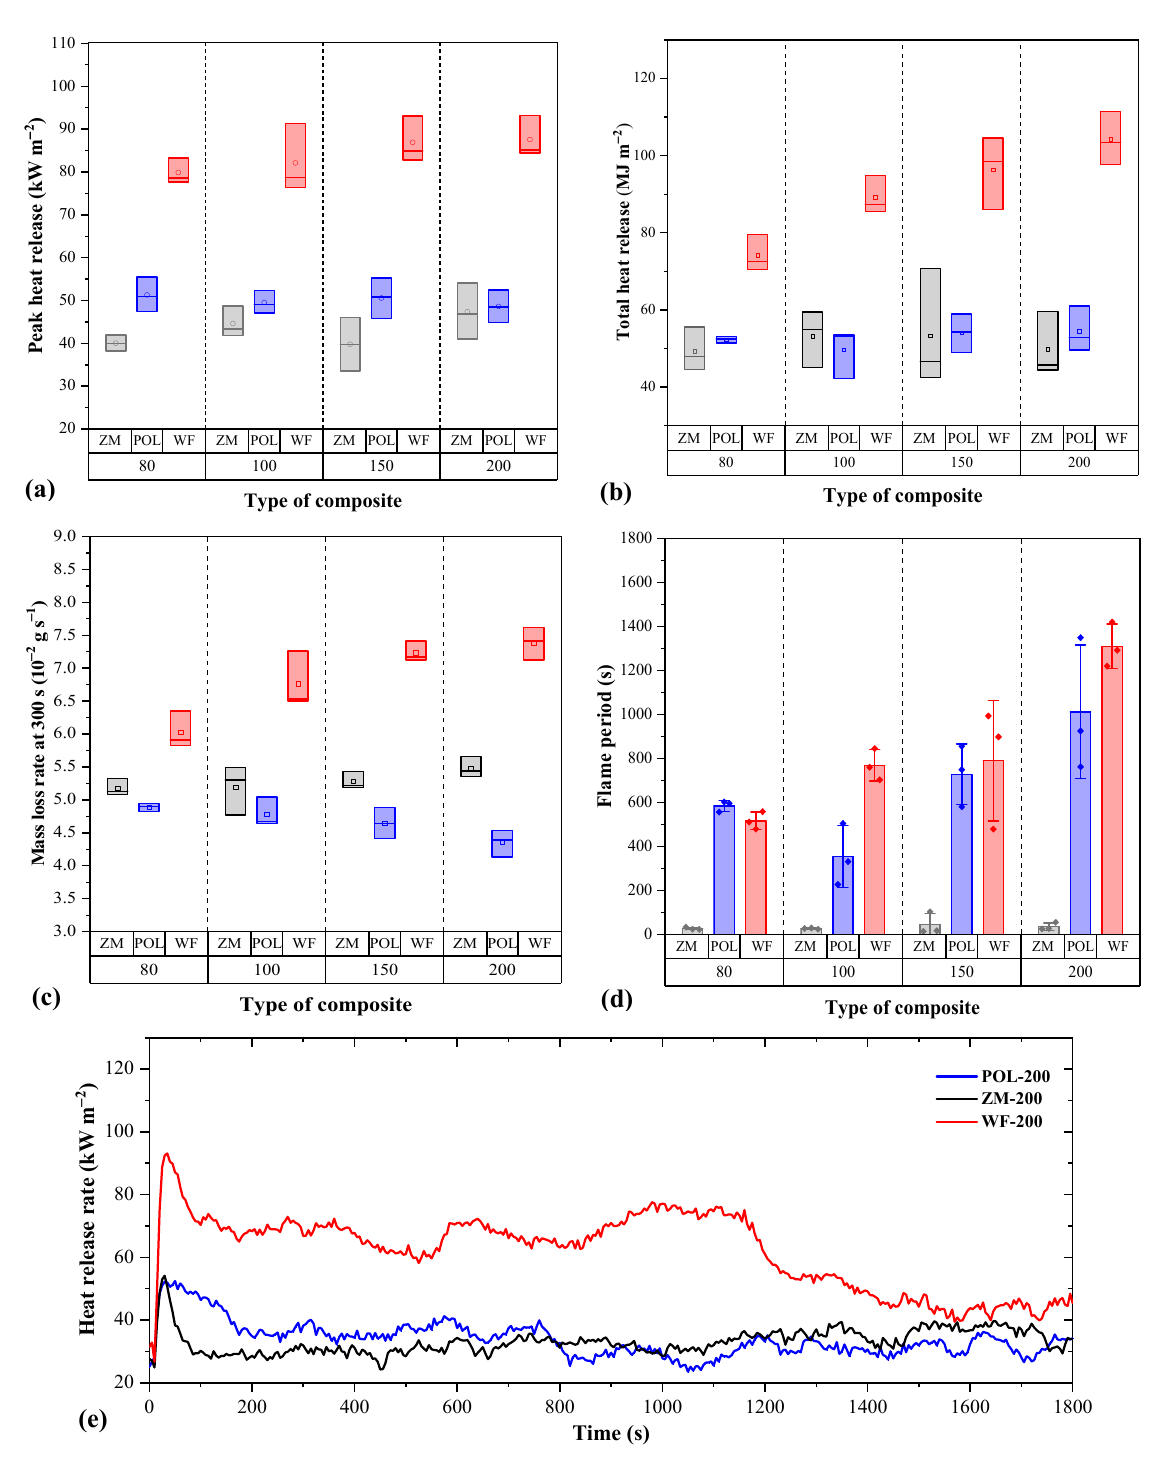
Figure 4. Fire properties of insulation boards of various densities determined with cone calorimetry. Peak heat release ( a ), total heat release for 1800 s ( b ), mass loss rate at the initial periods (300 s) ( c ), flame period (difference between ignition and flameout) ( d ), heat release rate for specimens with the target density of 200 kg m − 3 ( e ). In plots ( a – c ), each box represents the standard deviation, the horizontal lines within the box represent the median, and the dots represent the mean value. In plot ( d ), the height of the column represents the mean value, the vertical line on each column represents the standard deviation, and the dots represent individual